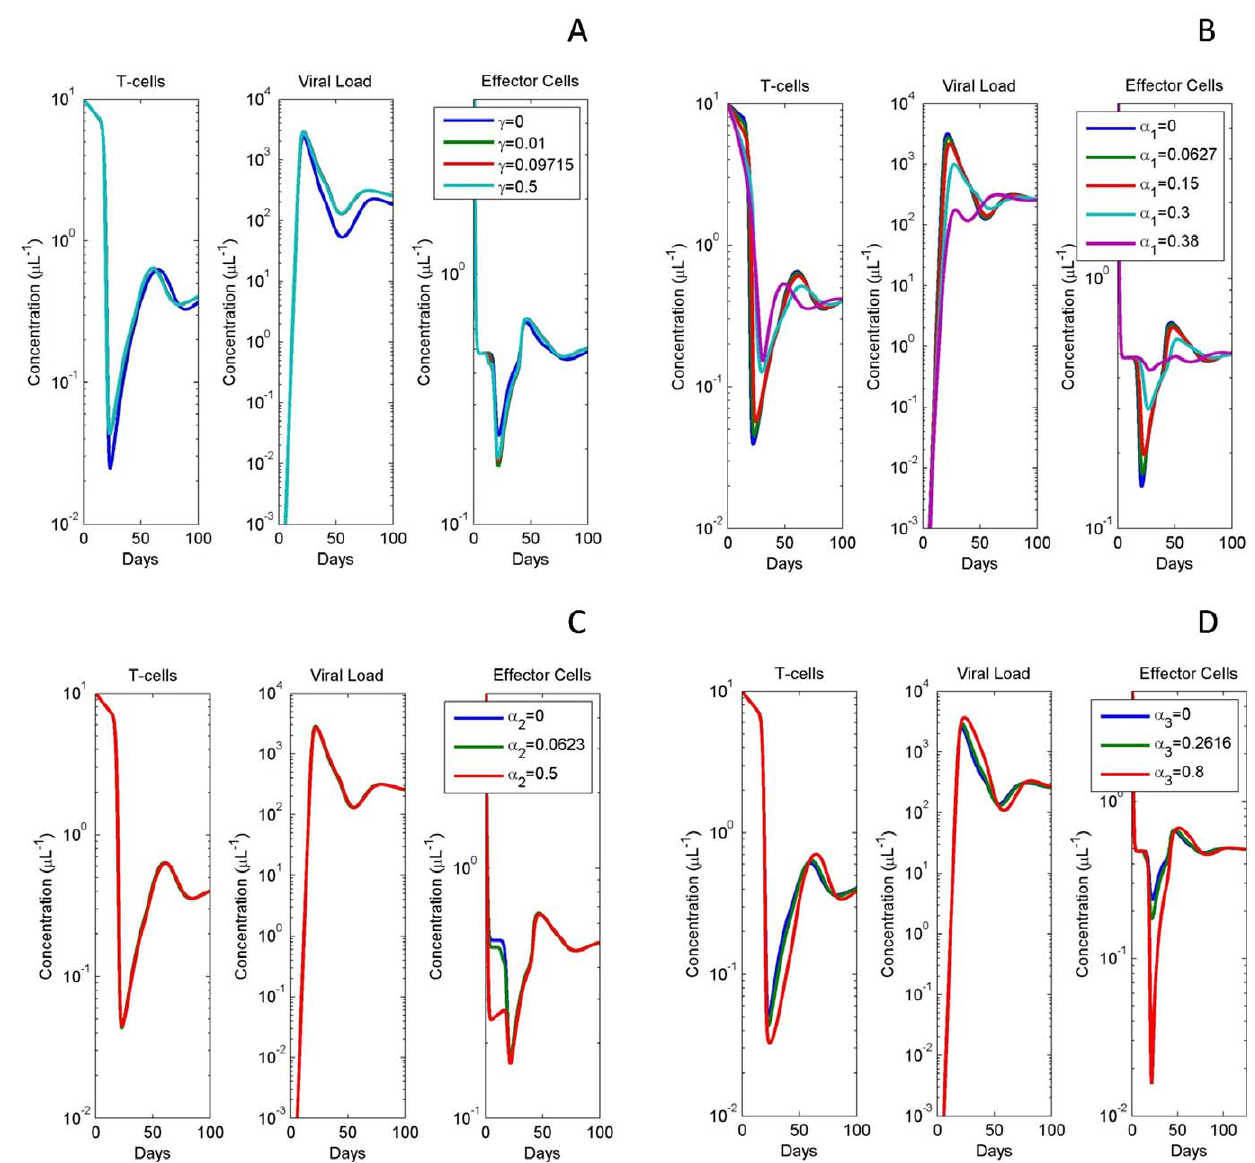
Figure 5. Plots of T-cell, Virus, and Effector populations with changes in regulatory T-cell parameters. Each distinct curve represents simulations from a unique randomly obtained, physiological parameter set. This figure depicts changes in T-cells, viral load, and effector cells given changes in regulatory T-cell parameters c , a 1 , a 2 , and a 3 : (A) c was varied and plotted alongside best fit of c ~ 0 : 09715 : It was seen that there were two very distinct behaviors; one behavior for c ~ 0 and one for c w 0 : For c ~ 0, viral load could be seen to stay lower and effector cells remained slightly elevated while T-cells remained slightly lowered. (B) a 1 was varied and plotted alongside the best fit for a 1 from data fitting which was a 1 ~ 0 : 0627 (days) 2 1 . All changes occur on the acute stages of infection and it is seen that for large values of a 1 , viral peak is significantly reduced. (C) a 2 was varied and plotted alongside the best fit of a 2 ~ 0 : 0623 (days) 2 1 . T-cell and viral load plots appear similar although it is seen that large values of a 2 result in a sharp decrease in effector population during acute infection. (D) a 3 was varied and plotted alongside best fit of a 3 ~ 0 : 2616 : It was seen that for large values of a 3 that effector population would drop drastically during the acute stage of infection and would result in a minor increase in viral load as well.